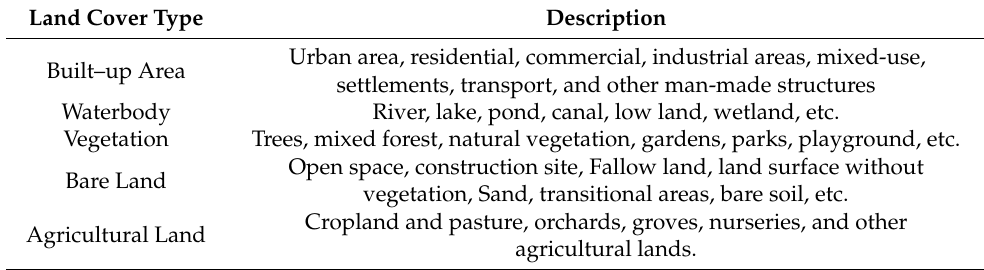
Table 2. Description of land cover